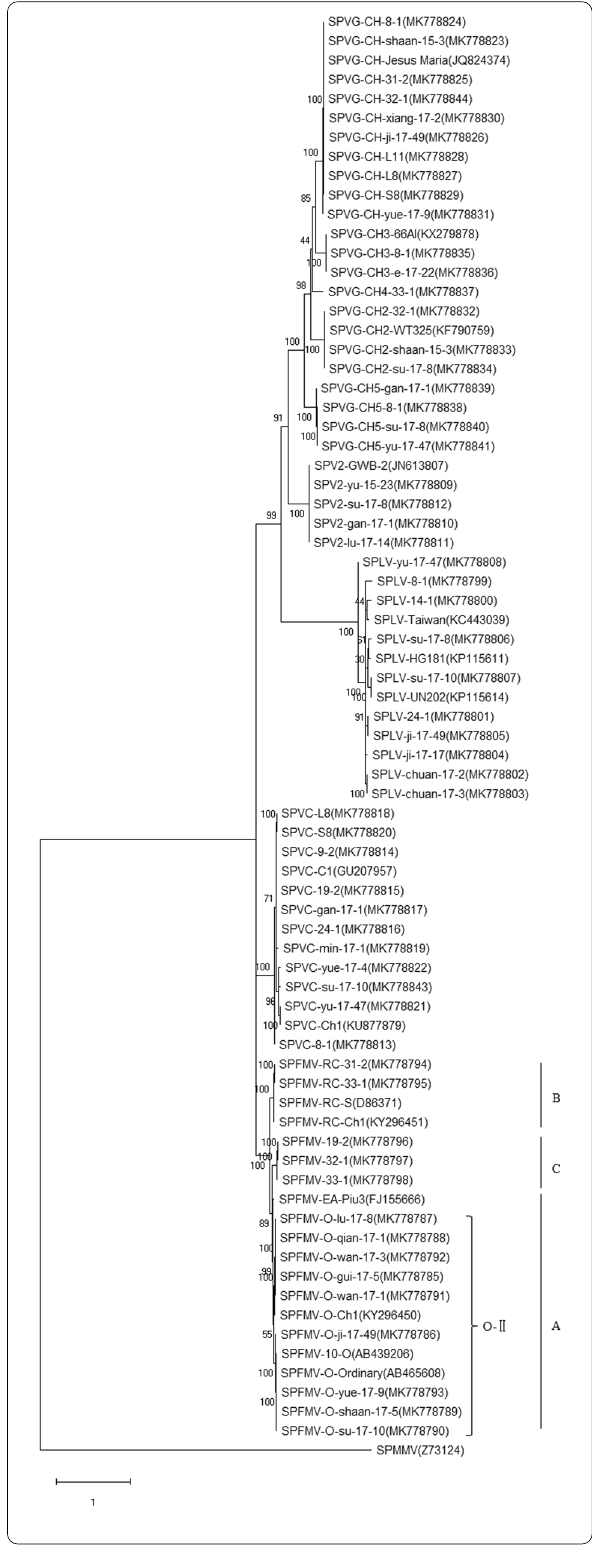
Fig. 1 Phylogenetic tree of polyprotein nucleotide sequences of SPFMV, SPLV, SPVG, SPVC and SPV2 isolates. The tree was generated using MEGA X (the Maximum Likelihood method, General Time Reversible model and 1000 bootstrap replicates). Sweet potato mild mottle virus (SPMMV; Z73124) was used as an outgroup taxon